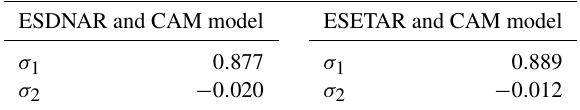
Table 6. CAM parameter estimates for the noise in the extended models. Note: “ESDNAR and CAM model” denotes the ESDNAR model with CAM noise, and “ESETAR and CAM model” denotes the ESETAR model with CAM